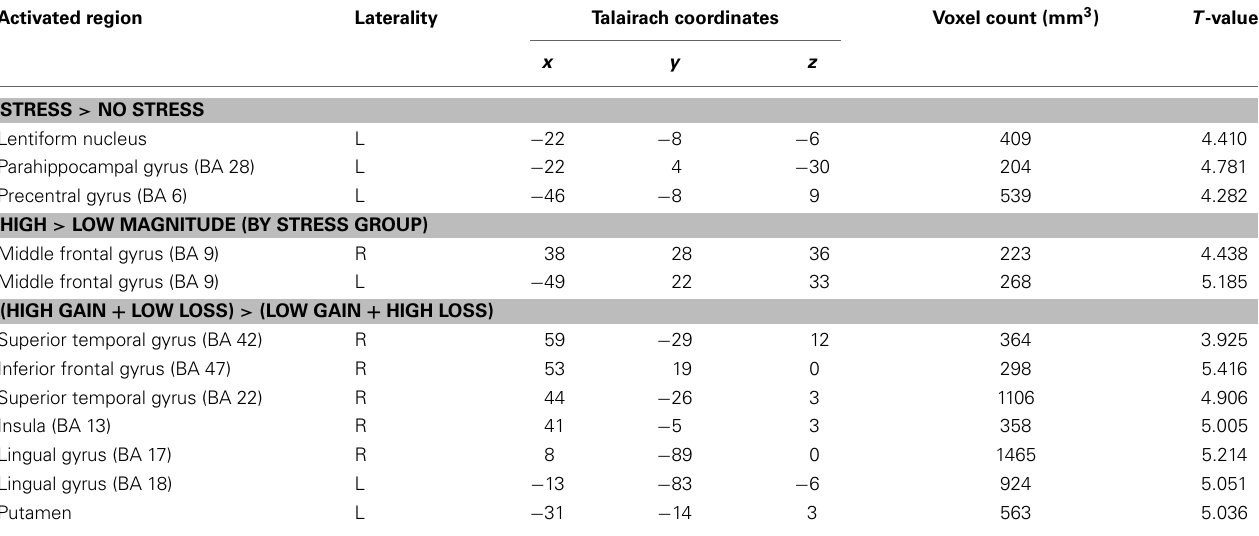
Table 4 | Regions of activation for simple other interaction contrasts; p < 0 . 005,